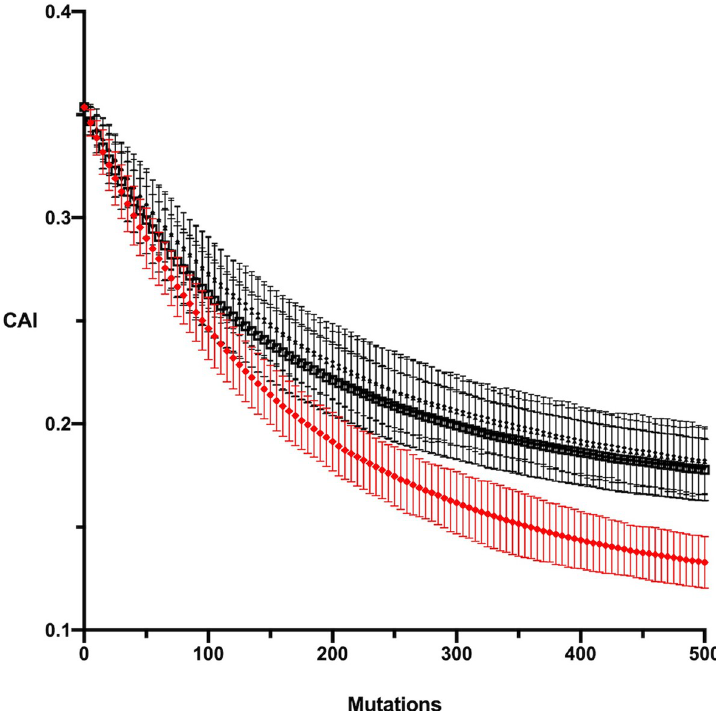
and Methods. The simulation results for the ML-AA ancestral psbA gene under each of the substitution models are shown in Fig 1. For the context-dependent models (MC and MC2020) both the synonymous and nonsynonymous simulations, the former restricted to synonymous